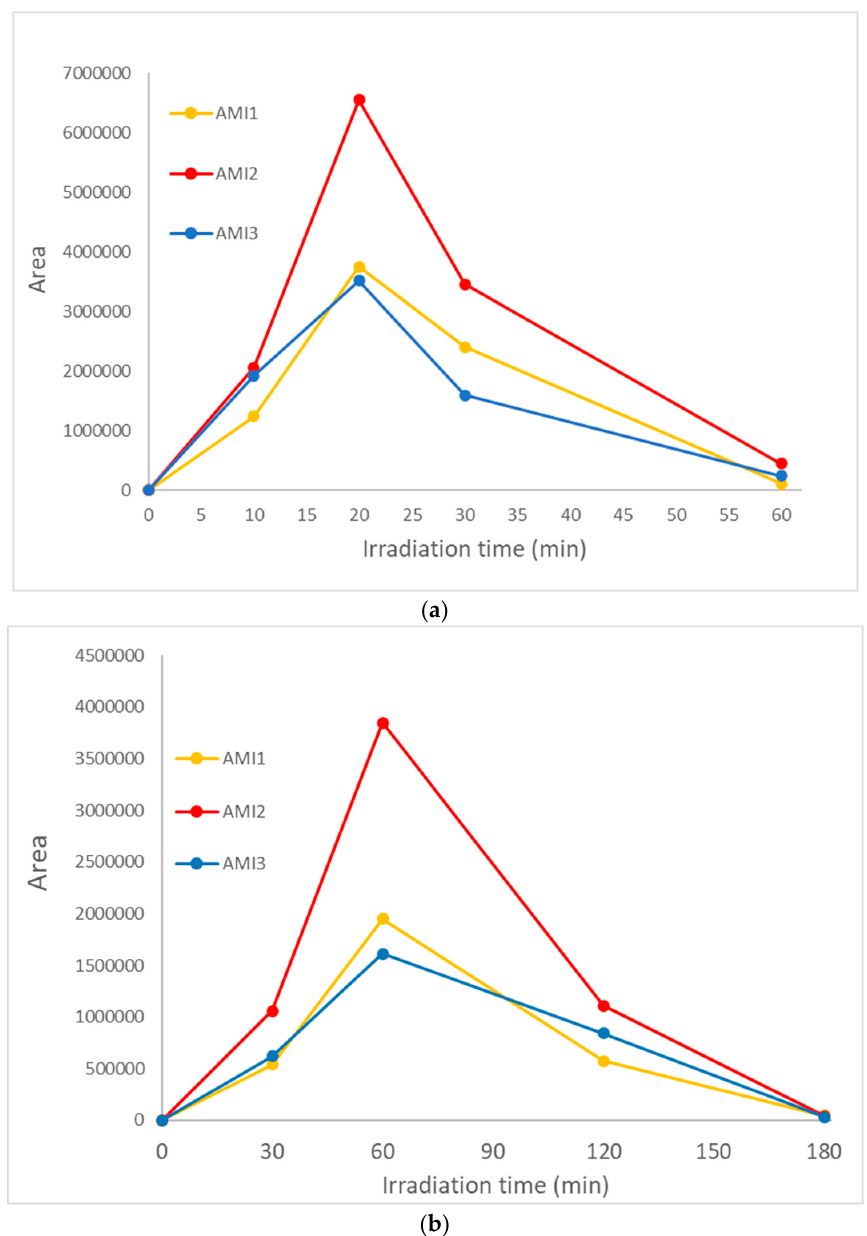
Figure 5. Evolution profiles of TPs identified during the photocatalytic degradation of amisulpride in: ( a ) UW; and ( b ) WW ([amisulpride] 0 = 1 mg L − 1 ; [g-C 3 N 4 ] = 300 mg L − 1